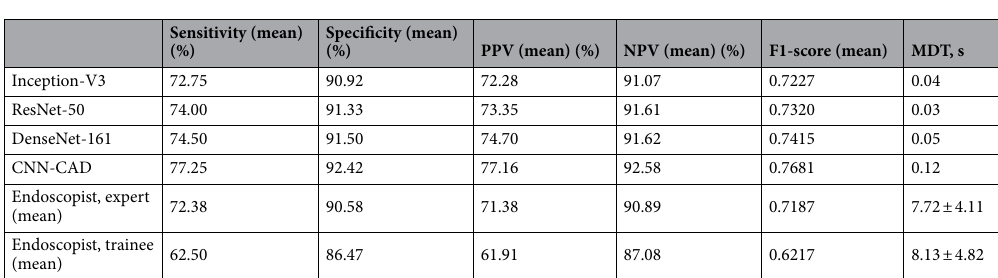
Table 3. Test result with performance comparison among the evaluated deep learning algorithms and endoscopists. NPV negative predictive value, MDT mean diagnostic time per image, PPV positive predictive value, s